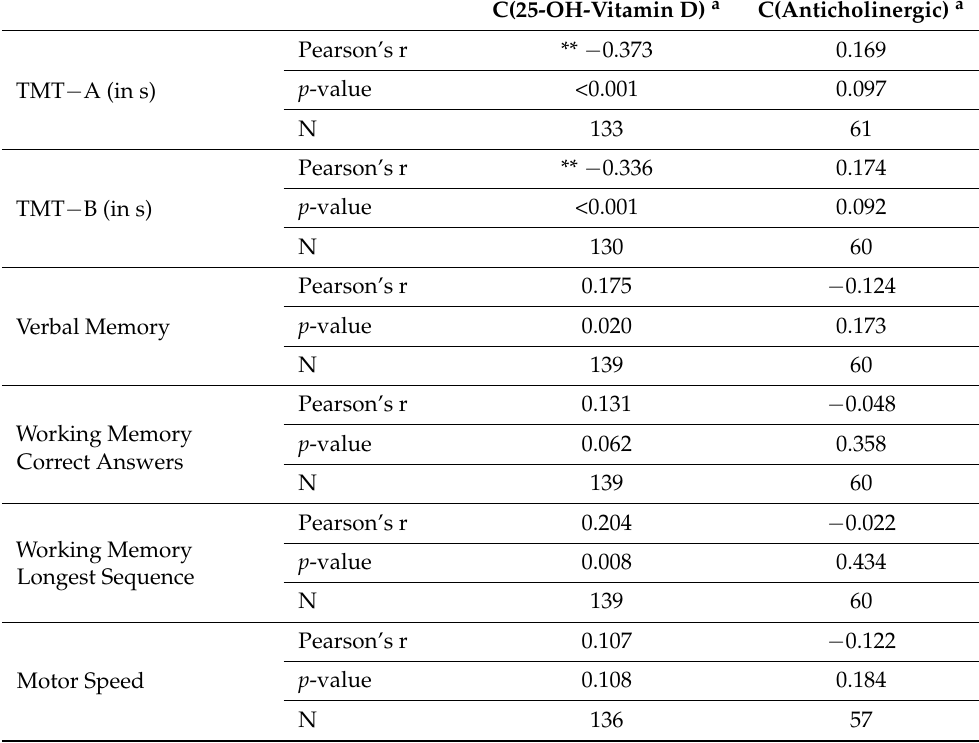
Table 2. Correlation